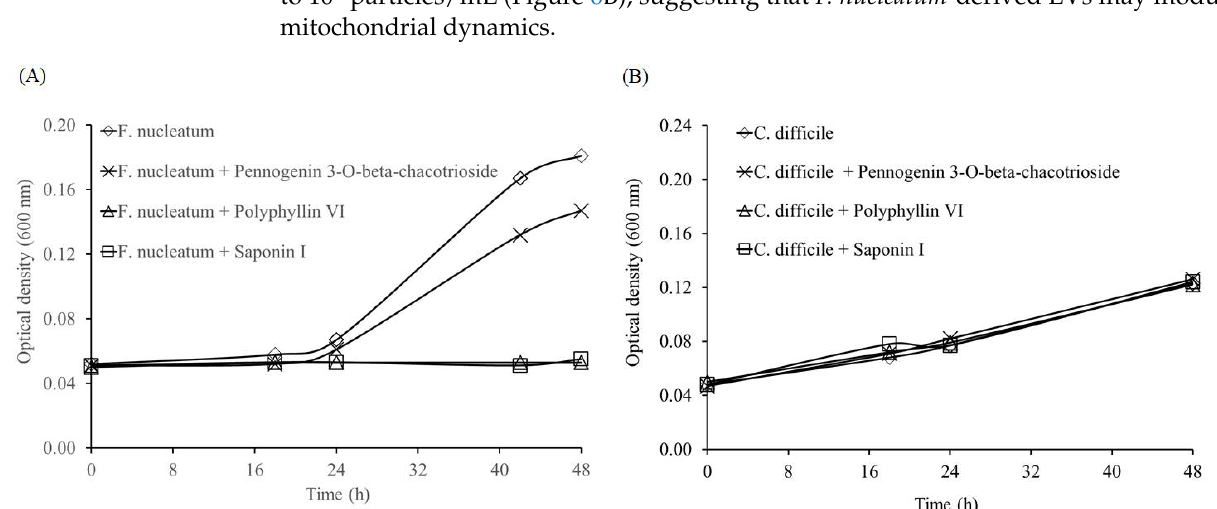
Figure 3. Effect of EEFPP on the growth in Caco-2 and HT-29 colorectal cancer cells. ( A ) Effects of EEFPP on cell morphology after 24 h treatment. ( B ) Crystal violet staining of cells after EEFPP treatment for 24 h. ( C ) Quantitative analysis of MTT and crystal violet staining (C. V) in cells treated with EEFPP for 24 h and 48 h. Data are shown as means ± SD ( n = 3). MTT data of Caco-2 are adopted from Figure 2B.